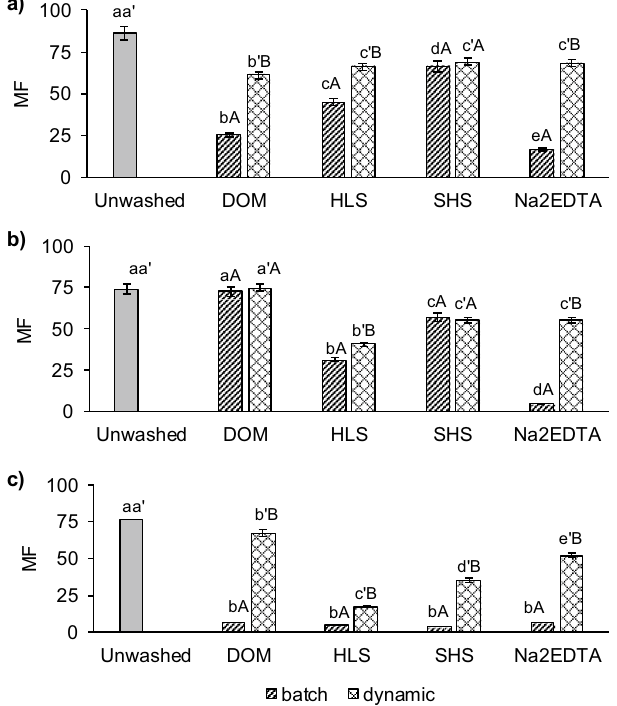
Figure 4. Mobility factor ( MF ) in unwashed soil and soil treated with different washing agents: ( a ) Cu, ( b ) Pb, and ( c ) Zn. Significant differences (mean ± SD, p < 0.05, Statistica 13.1) for MF between soils washed under batch conditions (abc), between soils washed under dynamic conditions (a’b’c’) and between washing conditions with the use of the same washing solution (AB) are marked with specific